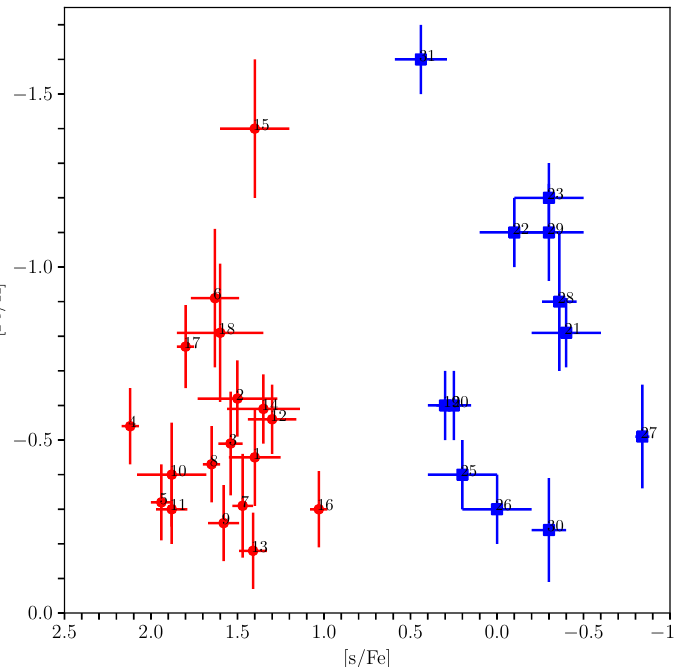
Figure 5. [s/Fe] versus metallicity. Within the post-AGB sample of Galactic, LMC and SMC stars, there is a wide variety of s -process enrichment which is independent of stellar metallicity. Many non-enriched objects which failed the third dredge-up are present as well. Figure adapted from [45]. The numbers in the figure refer to specific objects, as reviewed in